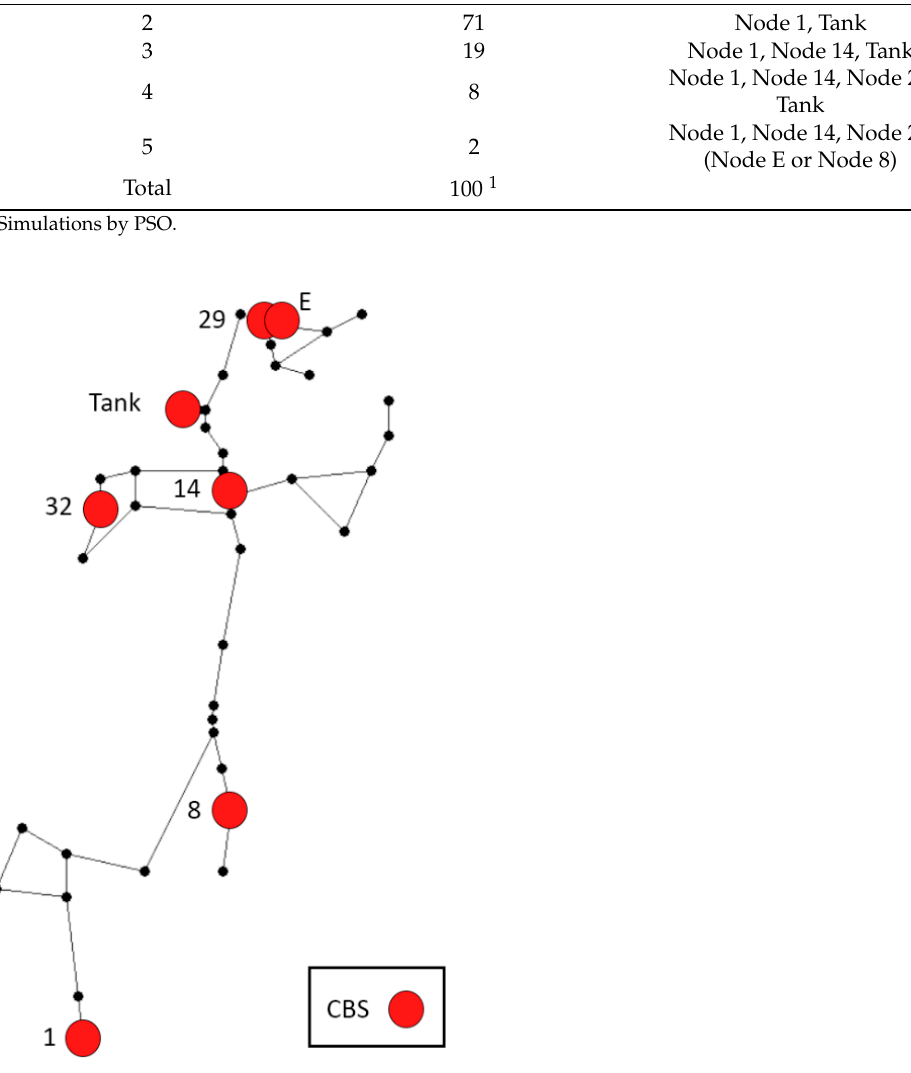
Figure 5. CBS location mostly proposed in Case Study 1.